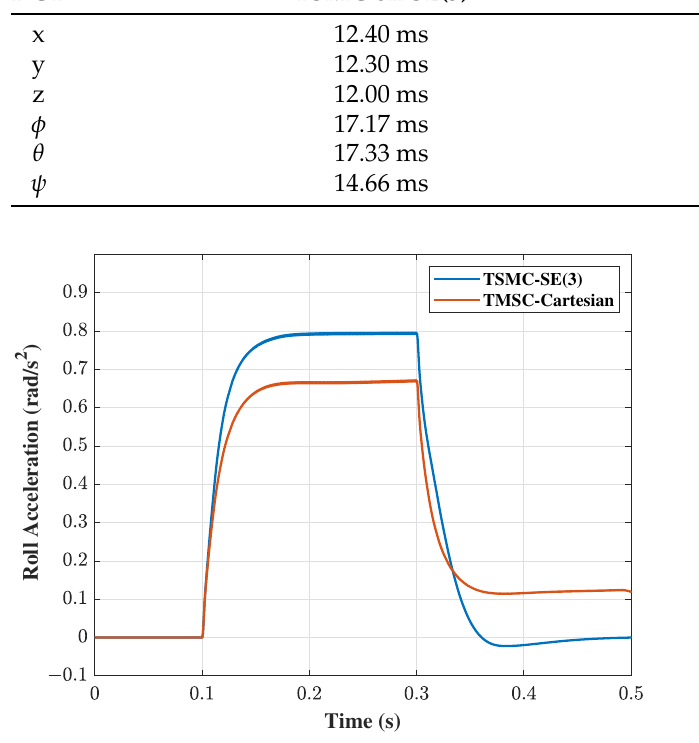
Figure 10. The step acceleration response comparison in the roll direction.